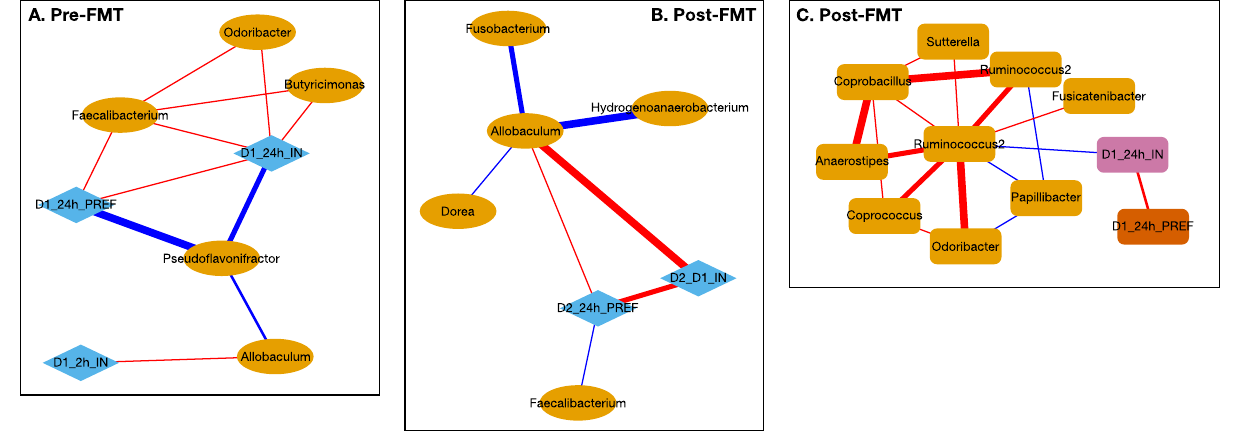
Fig. 7 | Correlation networks between alcohol intake and preference and stool microbial genera. Red Edge: positive, Blue Edge: negative correlation, D1_2hI_IN: binge intake day 1, D1_24h_PREF: 24h preference day 1, D1_24h_IN: day 1 intake, D2_24h_PREF: 24h preference day 2, D2_D1_IN: total intake, Pink nodes are micro- bial genera. Pre-FMT are mice colonized with stoolfrom donors before FMT,while